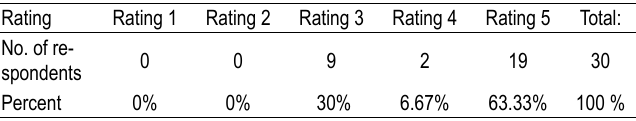
Table 6. Status of patients after